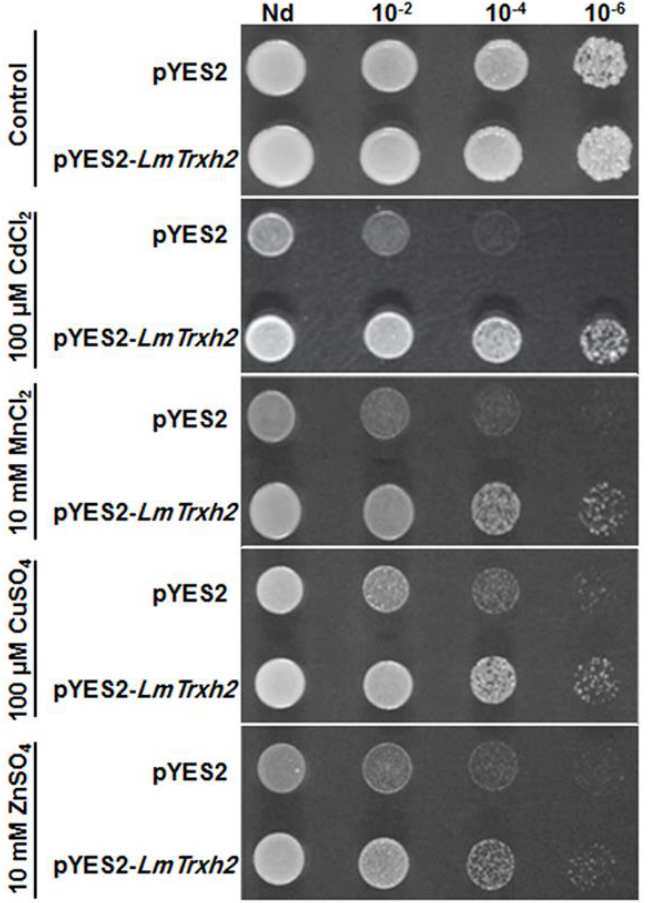
Figure 2. Expression of the LmTrxh2 gene confers the heavy metals stress tolerance of LmTrxh2 - transformed yeast.